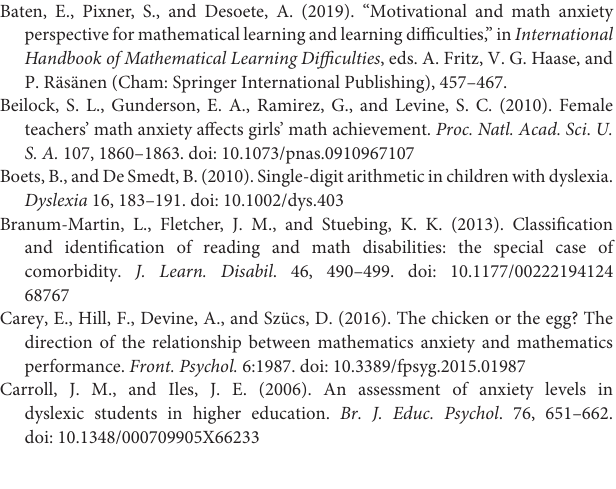
Supplementary Figure 1 | Predicted mathematics competence (top panel) and reading competence (bottom panel) from the regression models. (A) shows the relation between predicted Broad Mathematics and math motivation for participants with lower reading anxiety (25th percentile) and higher reading anxiety (75th percentile) (see Table 4 , Model B5). (B) shows the analogous relation for predicted Math Fluency (see Table 5 , Model F4). (C) shows the relation between predicted Total Word Reading Efficiency and reading motivation (see Table 6 , Model T4). (D) shows the relation of predicted Basic Skills and reading motivation for boys and girls (see Table 7 , Model S5). For all graphs, KBIT2 is set to the sample mean. In (D) , participant age is also set to the sample mean ( n = 146). Supplementary Table 1 | Descriptive statistics for age, math and reading competence, and socio-emotional measures, by group (n = 143). Note, we exclude the three participants who had math disability only due to insufficient sample